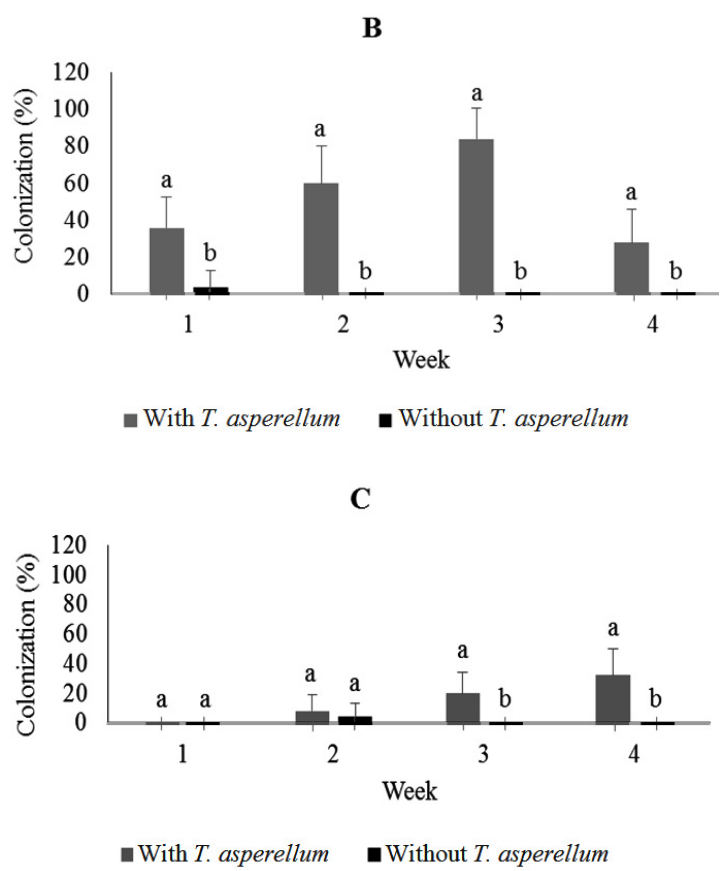
Fig. 2. Colonization of Trichoderma asperellum in stem (B) and root (C) tissues at one, two, three, and four weeks post-inoculation through stem infusion. The fungus was not detected in leaf tissues. Means of colonization at the same time followed by the same letter are not significantly different according to T-test (P<